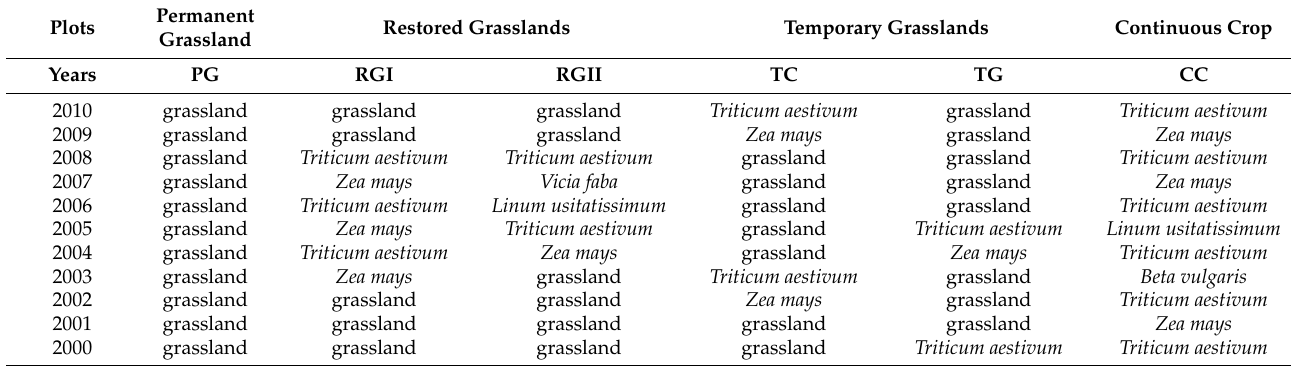
Table 2. Description of the cropping history of the plots since